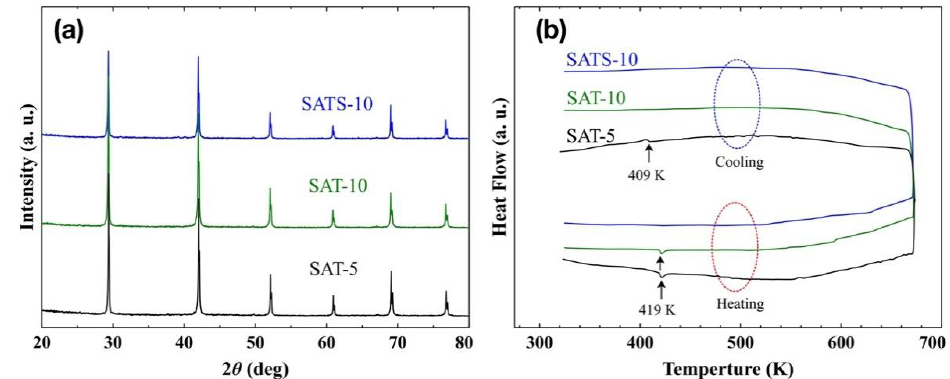
Figure 1. ( a ) Powder X-ray diffraction (XRD) patterns and ( b ) differential scanning calorimetry (DSC) heat flow curves of SAT-5, SAT-10 and SATS-10 films developed by melt spinning (sample mass, 10 mg).